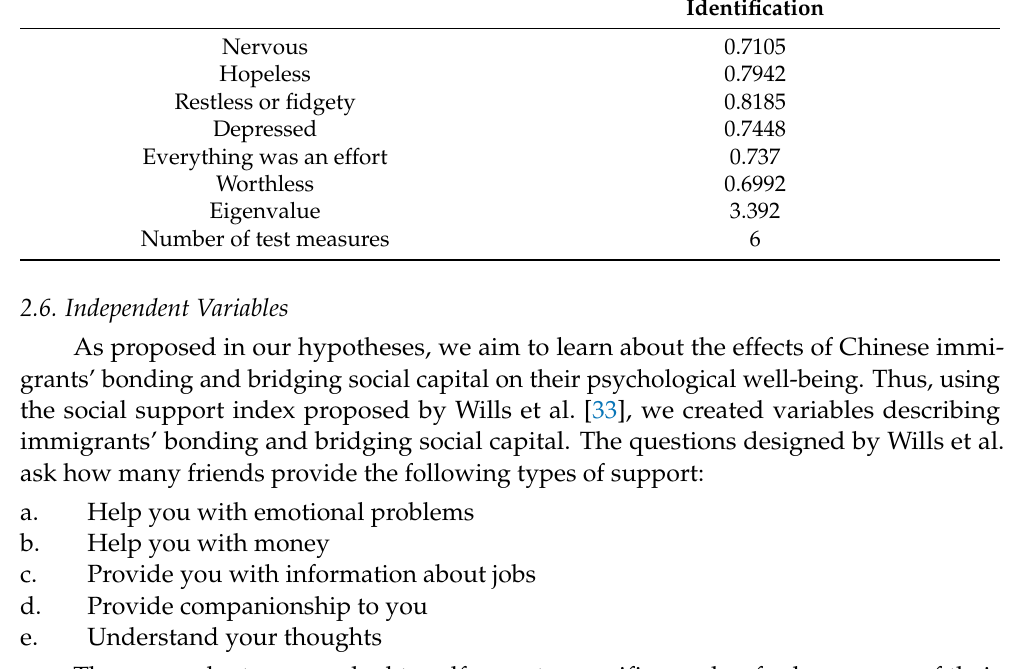
Table 3. Summary of results from exploratory factor analysis of psychological well-being. Item Factor Loading Nervous 0.7105